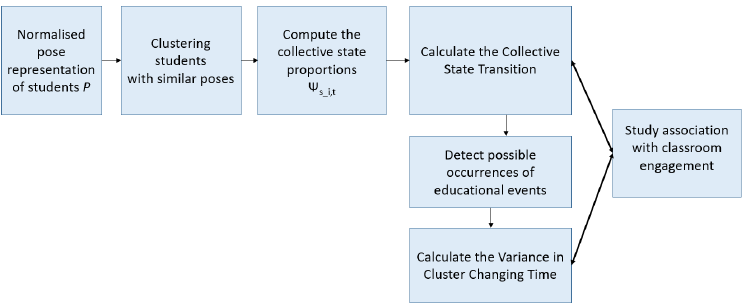
Figure 4. Method to calculate a measure for collective behaviour and a measure for the reaction time to classroom